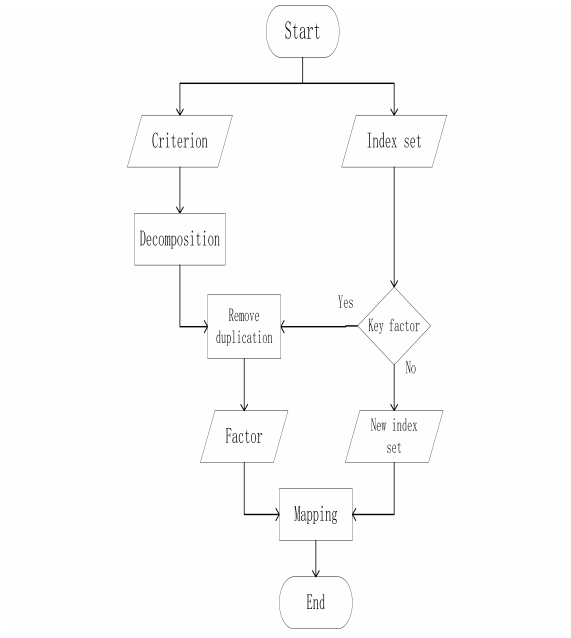
Figure 3. The processing flow of system